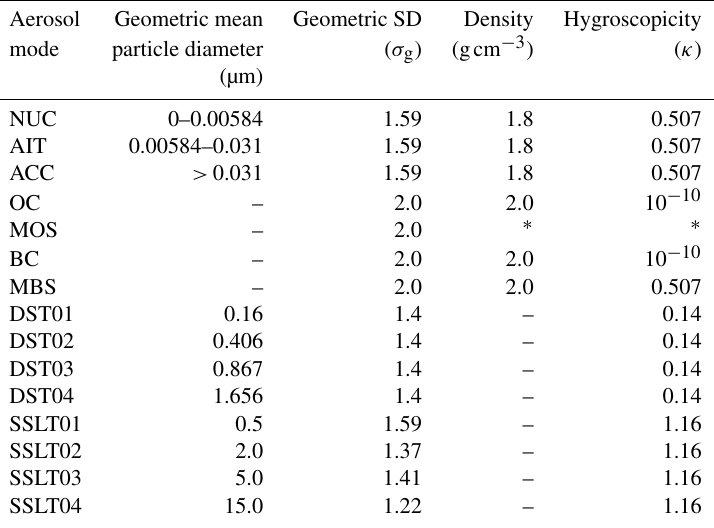
Table 1. MARC aerosol mode size distribution and chemistry parameters. The MOS mode ( ∗ ) has a composition-dependent density and hygroscopicity which is computed using the internal mixing state of organic carbon and sulfate present at a given grid cell and